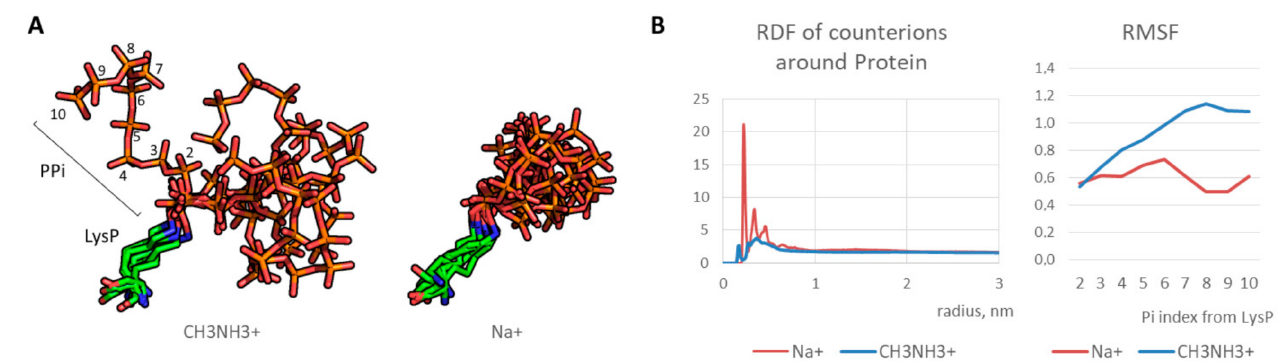
Figure 2. ( A ) Typical states of LysP-PP i chain for 50–100 ns (every 10 ns): stable position in case of Na + and dynamic state in case of CH 3 NH 3+ ; ( B ) radial distribution function (RDF) graphs for counterions and mobility of PP i residues (in terms of root mean square fluctuation, RMSF).